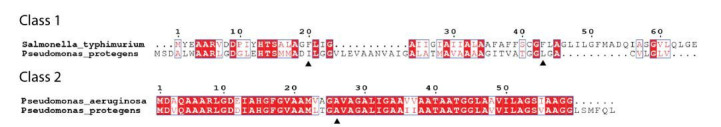
Figure showing the alignment of Class 1 (SciW and EagR1) and Class 2 (EagT6 and Tne2) prePAAR-TMD regions studied in this manuscript.The black arrows indicate the residues that may contribute to asymmetric vs. pseudosymmetric binding.